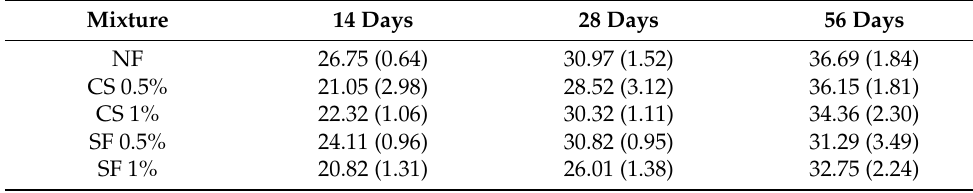
Table 7. Compressive strength results for base dosage of 23.54 MPa.